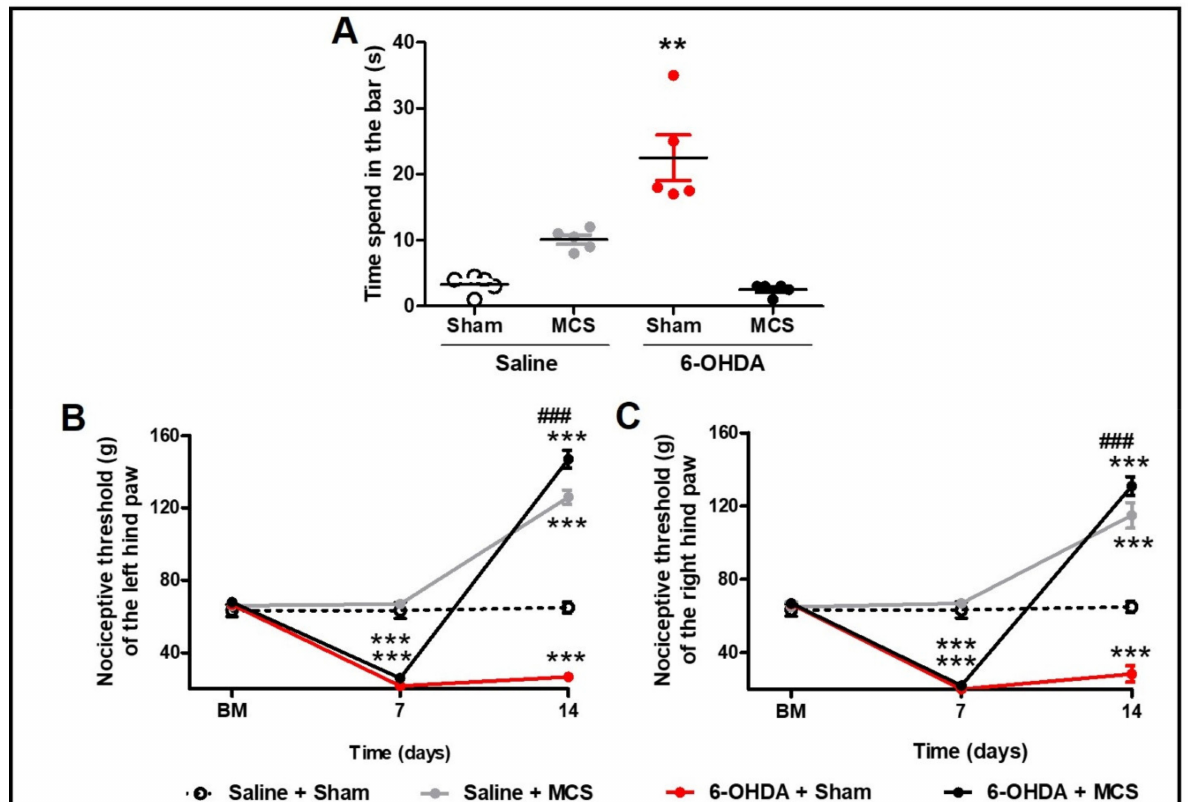
Figure 2. Motor and nonmotor symptoms. Rats were evaluated in relation to behavioral immobility in the bar test ( A ) 14 days after the striatal injection. The values represent the mean ± SEM (n = 5 per group). ** p < 0.01 when compared to saline + sham group (1-w-ANOVA followed by Tukey post-hoc test). Rats were evaluated in relation to nociceptive threshold in the paw pressure test in the left ( B ) and right ( C ) hind paws. Nociceptive behavior was evaluated before (basal measurement, BM), and 7 and 14 days after striatal injection. Fourteen days after the striatal injection, the motor cortex stimulation (MCS) was applied in a single 15-min session (1.0 V, 60 Hz, and 210 µ s). The values represent the mean ± SEM (n = 5 per group). ** p < 0.01; *** p < 0.001 when compared to saline + sham group; ### p < 0.001 when compared to 6-OHDA + sham group (2-w-ANOVA followed by Bonferroni’s post-hoc